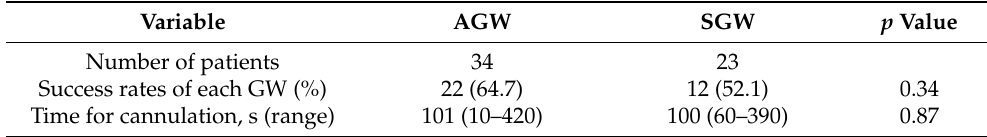
Table 2. Successful selective biliary cannulation rate and time for cannulation for 14 min. Variable AGW